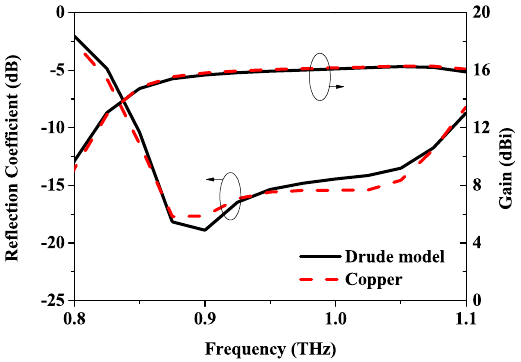
Figure 13. Comparison of simulated results for the antenna array using the ideal copper model and the Drude